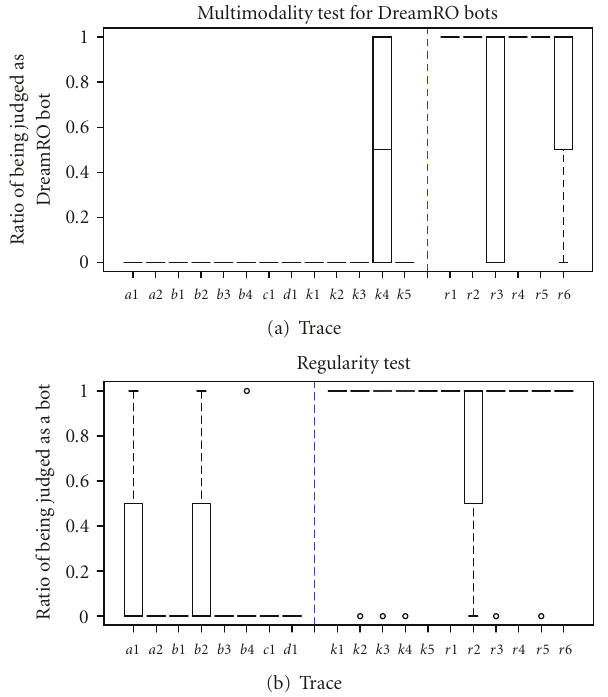
Figure 14: Bot identification results using the command timing method which comprises the multimodality test and the regularity test.